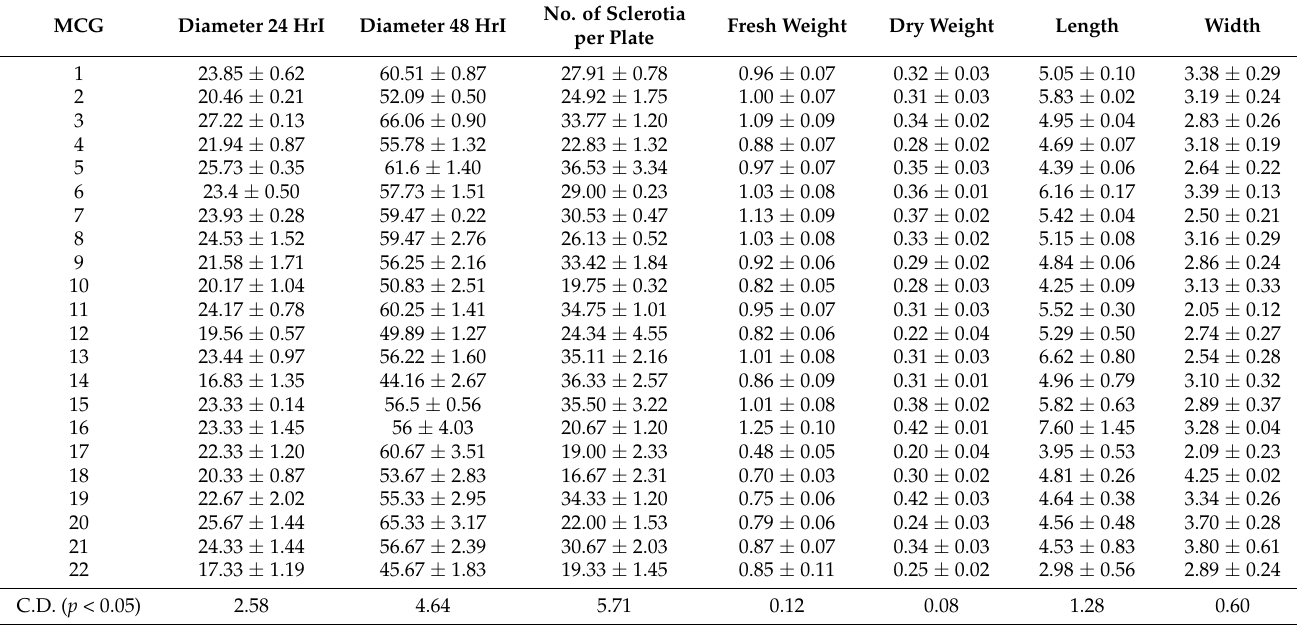
Table 5. Morpho-cultural variability between 22 MCGs formed by 80 S. sclerotiorum isolates collected from